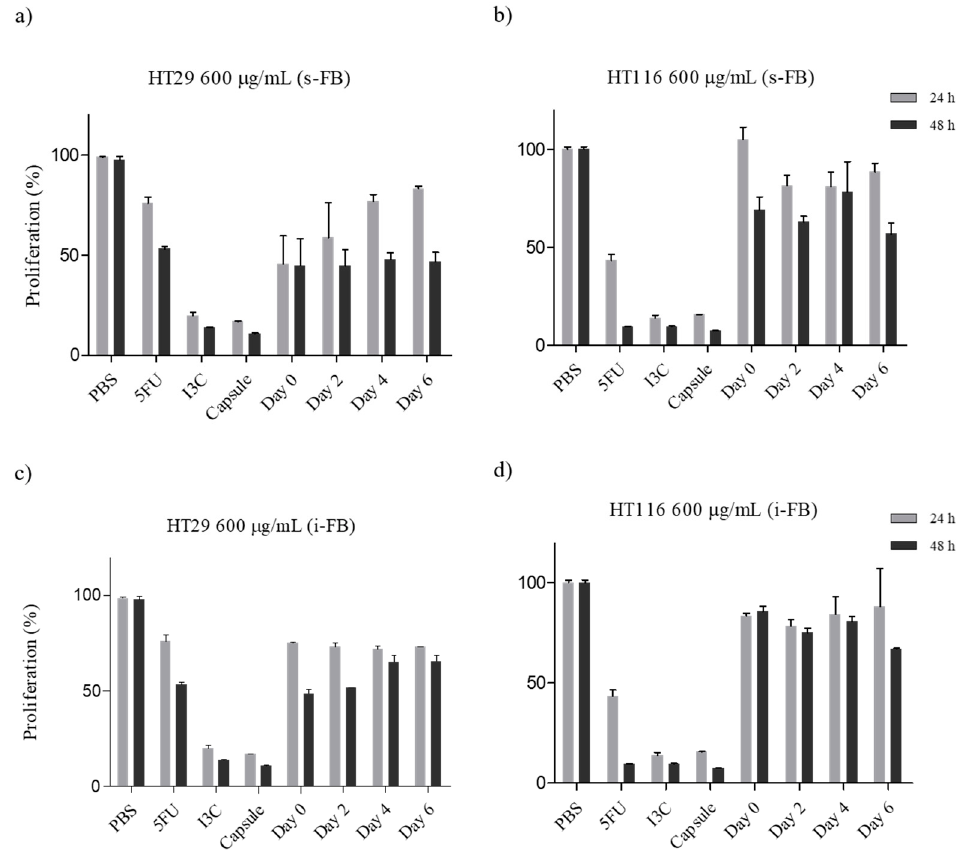
Figure 6. Antiproliferative effects of fermented broccoli on HT26 and HT116 cell lines at 24 and 48 h (600 µg/mL). ( a ) Antiproliferative effect of s-FB on HT29 cells, ( b ) antiproliferative effect of s-FB on HT11629 cells, ( c ) antiproliferative effect of i-FB on HT29 cells, and ( d ) antiproliferative effect of i-FB on HT116 cells. 5FU (5-fluoroacil); I3C (indole-3-carbinol, Sigma); Capsule (Commercial capsule of I·C with cruciferous vegetables, Solaray ® ).